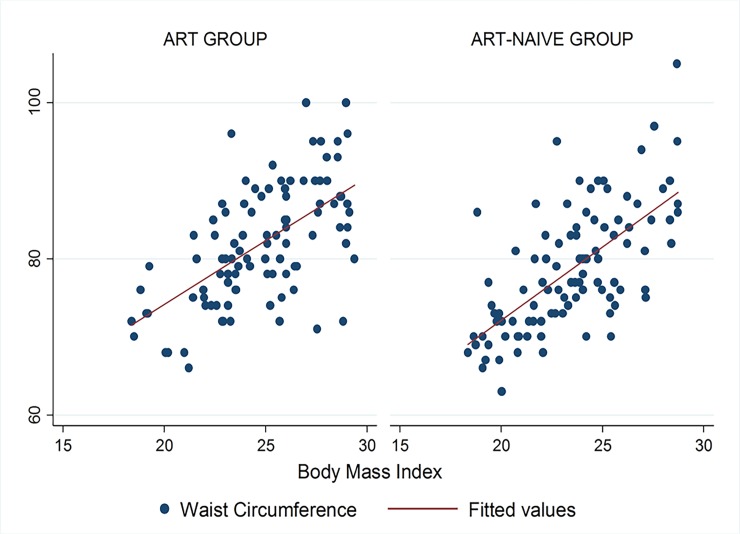
Linear regression model of the association between WC and BMI according to HAART status.